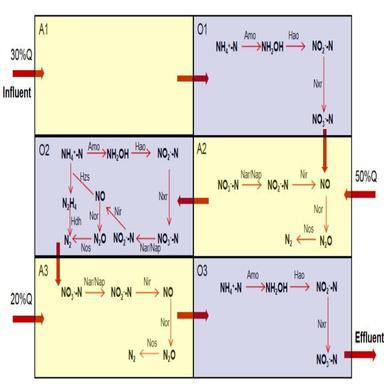
Nitrogen metabolism pathway (a) and functional gene heatmap (b) in different zones.